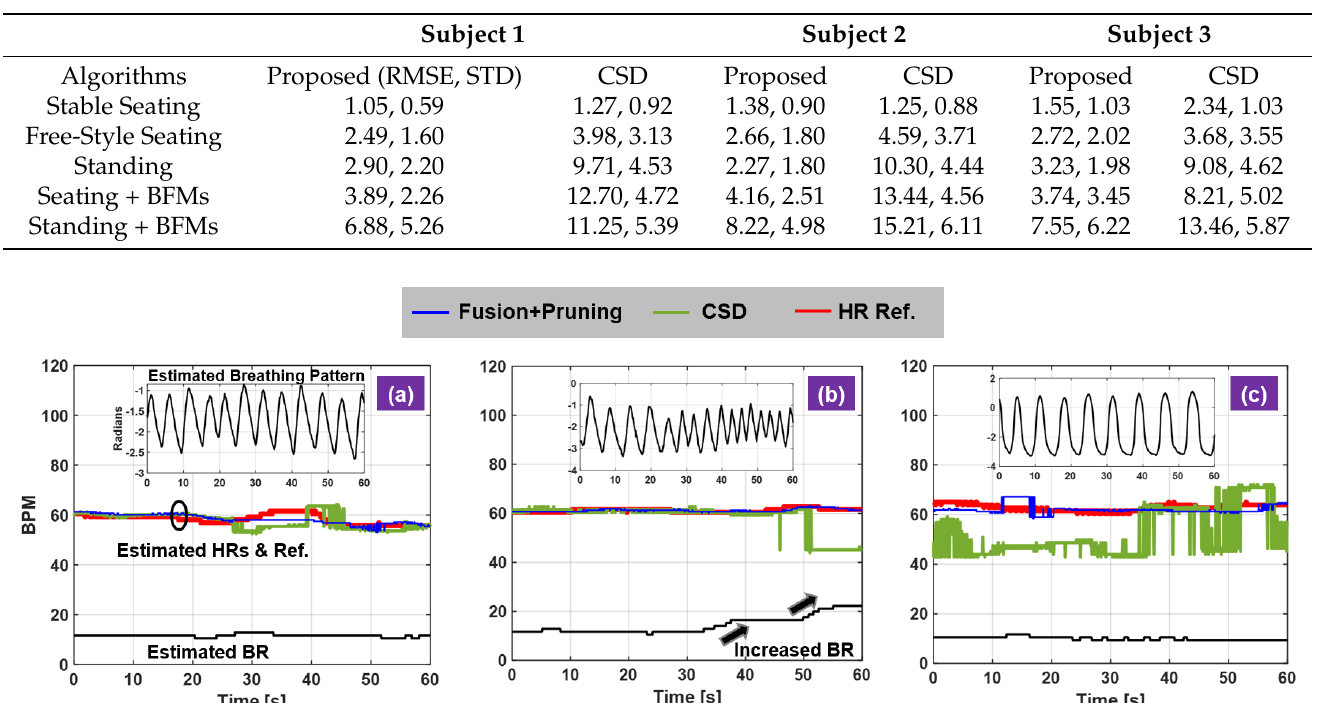
Table 1. Summary of HR Estimation Error Statistics (BPM) in Various Scenarios.